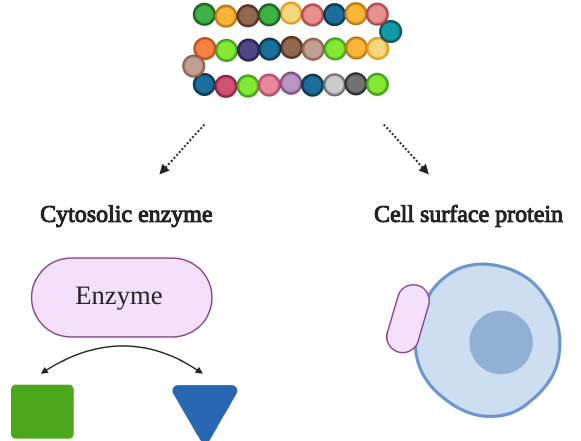
Figure 1. In a moonlighting protein (purple oval), more than one physiologically relevant biochemical or biophysical function is performed by a single polypeptide chain. Note: This figure was “Created with